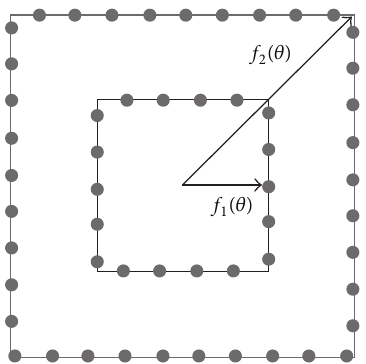
Figure 3: A large number of the feature points describe the bound- ary functions.